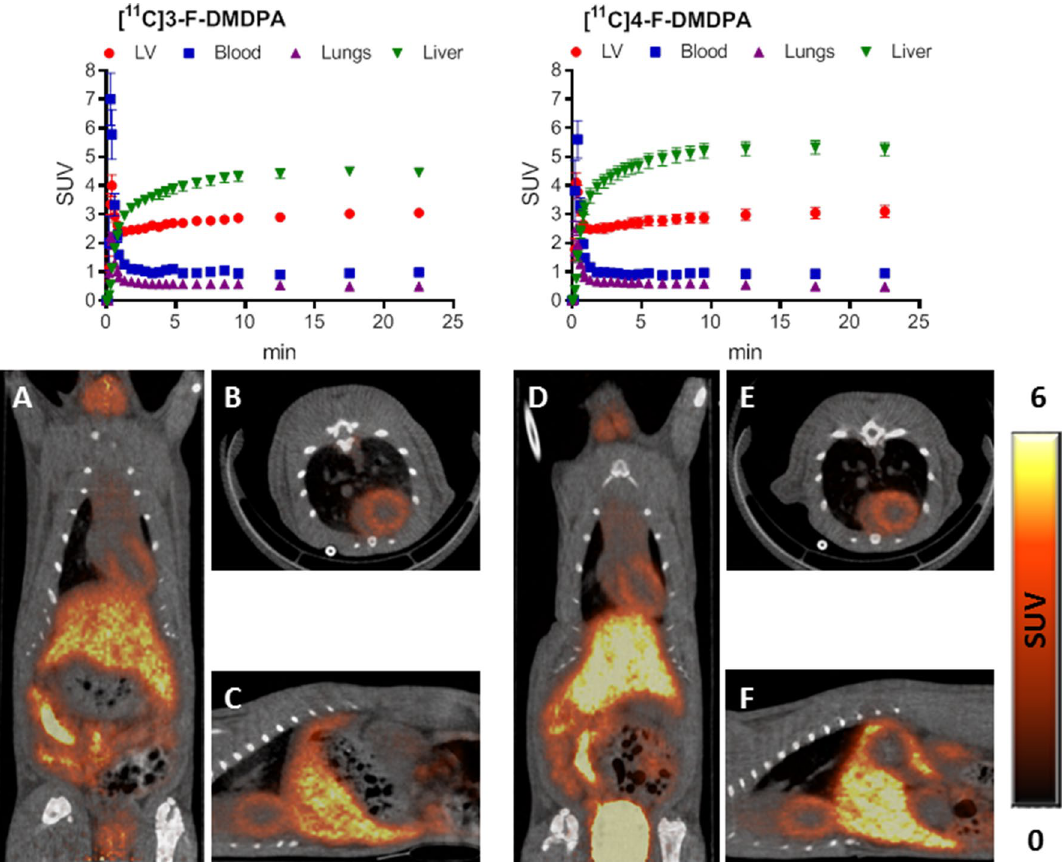
Figure 4. TACs of selected organs following i.v. injection of [ 11 C]3-F-DMDPA (upper left, n = 5) and [ 11 C]4-F- DMDPA (upper right, n = 6) into male SD rats. Results are presented as mean ± SEM. Representative PET/CT of coronal ( A , D ), axial ( B , E ), and sagittal ( C , F ) slice images obtained following i.v. injection of [ 11